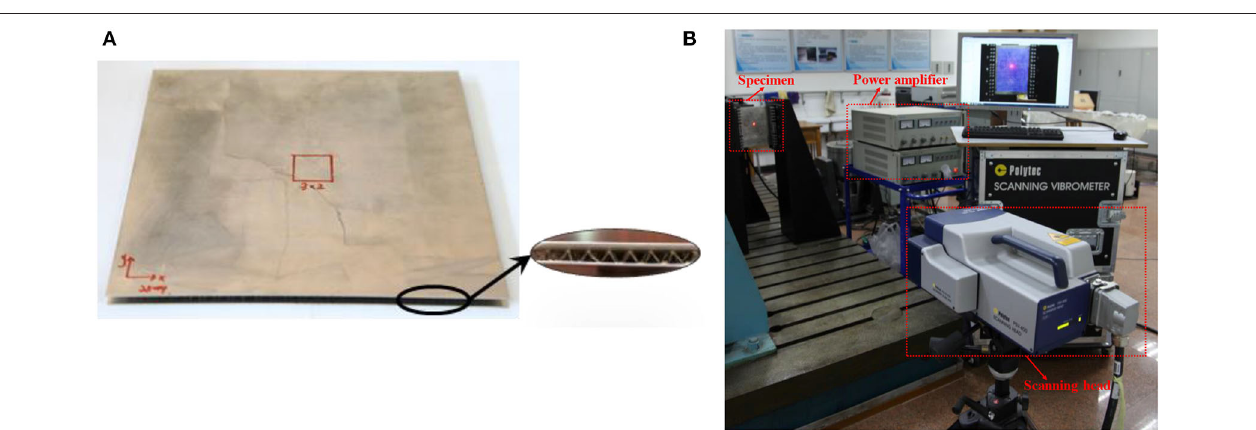
FIGURE 3 | Experimental information. (A) Damaged specimen (SD1). (B) Experimental set-up.